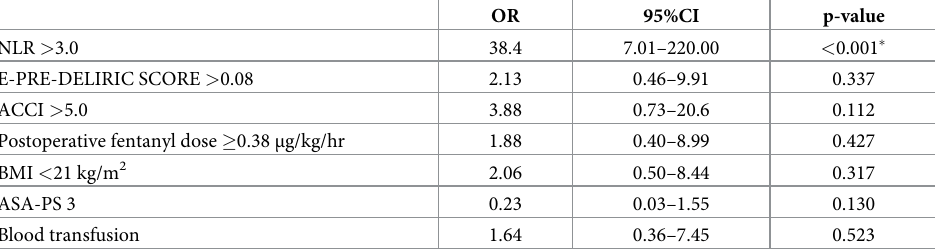
Table 4. Multivariate logistic regression analysis results. OR 95%CI p-value NLR > 3.0 38.4